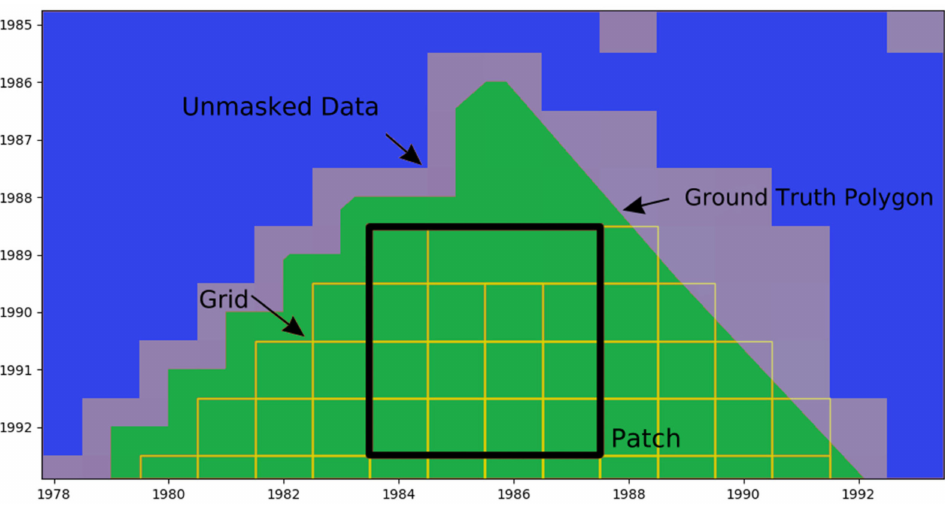
Figure 5. Automatic patch-generating process for a patch of 4 × 4 size.